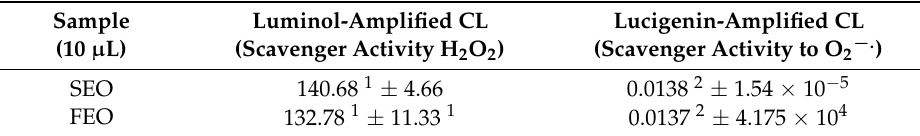
Luminol-amplified- and lucigenin-amplified chemiluminescence (CL) of SEO and FEO. Antioxidant activity toward H 2 O 2 and O 2 − . produced in the Luminol-amplified- and lucigenin-amplified-system respectively, was quantified using known amounts of superoxide dismutase (SOD) and catalase (CAT) enzymes. p > 0.05.